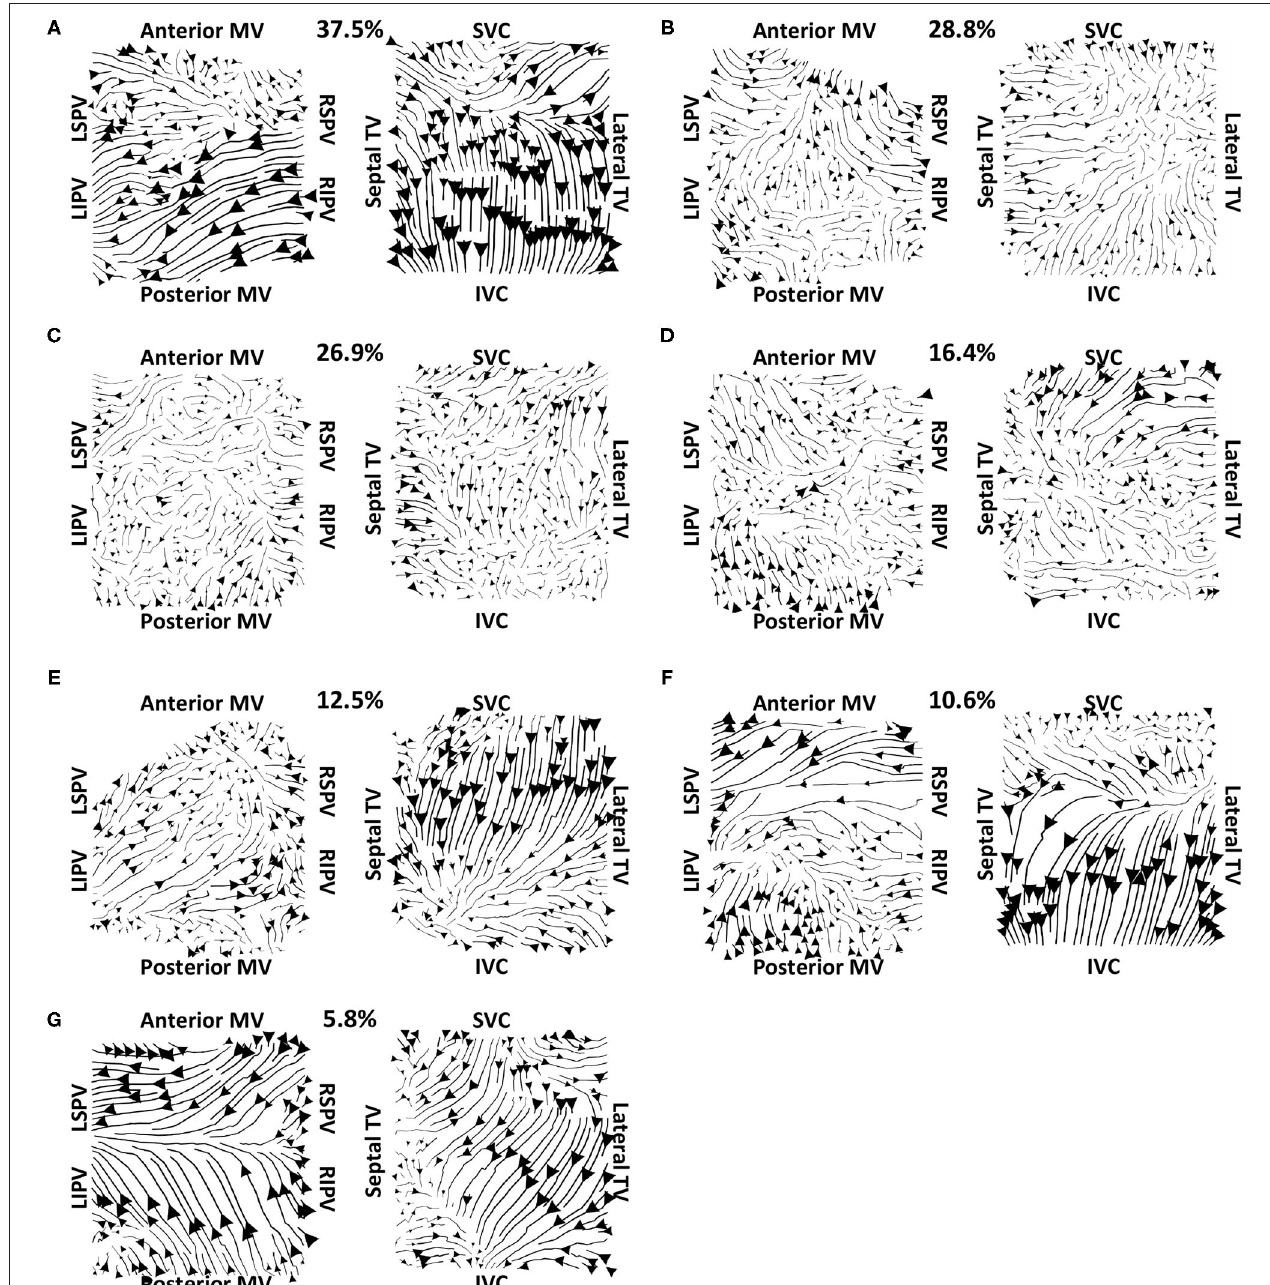
FIGURE 6 | Clinical average vector fields demonstrate activation flow from the PV antra into the atrial body for PVI responder cases pre-ablation. Paths are shown for the left and right atria as streamlines with the magnitude dependent on the magnitude of the underlying average vector field, signifying how often a direction is repeated. The direction of the centre of each streamline is also indicated. Cases are arranged in order of decreasing PV activation flow metric: (A) 37.5%, (B) 28.8%, (C) 26.9%, (D) 16.4%, (E) 12.5%, (F) 10.6%, and (G) 5.8%.